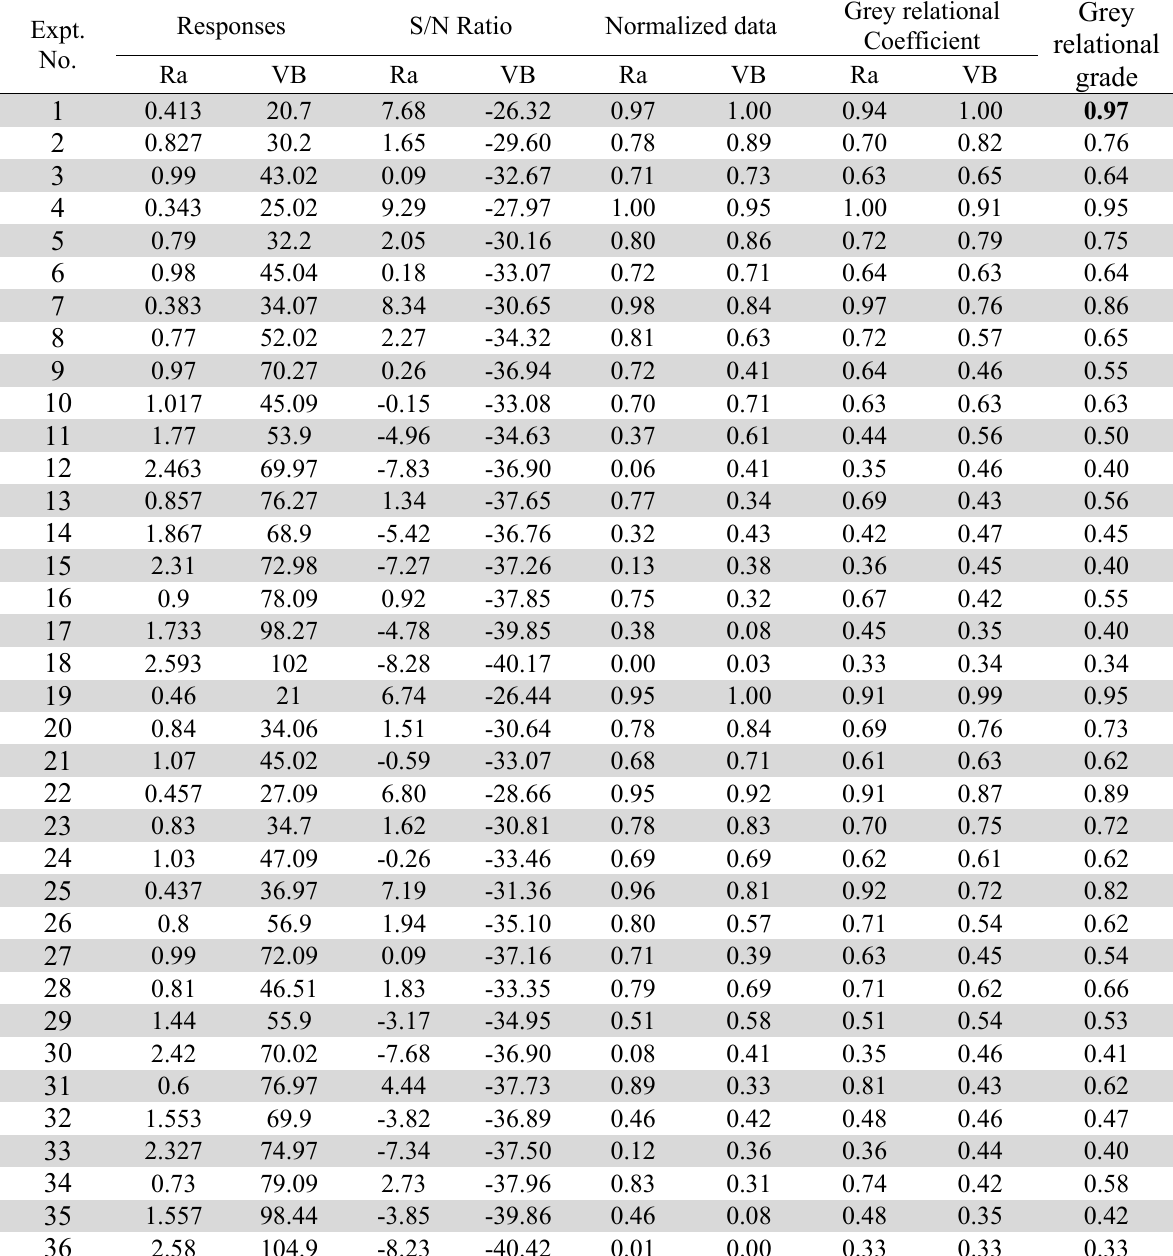
Observed response values, S/N ratio of responses, normalized values, grey relational coefficient and grey relational grade